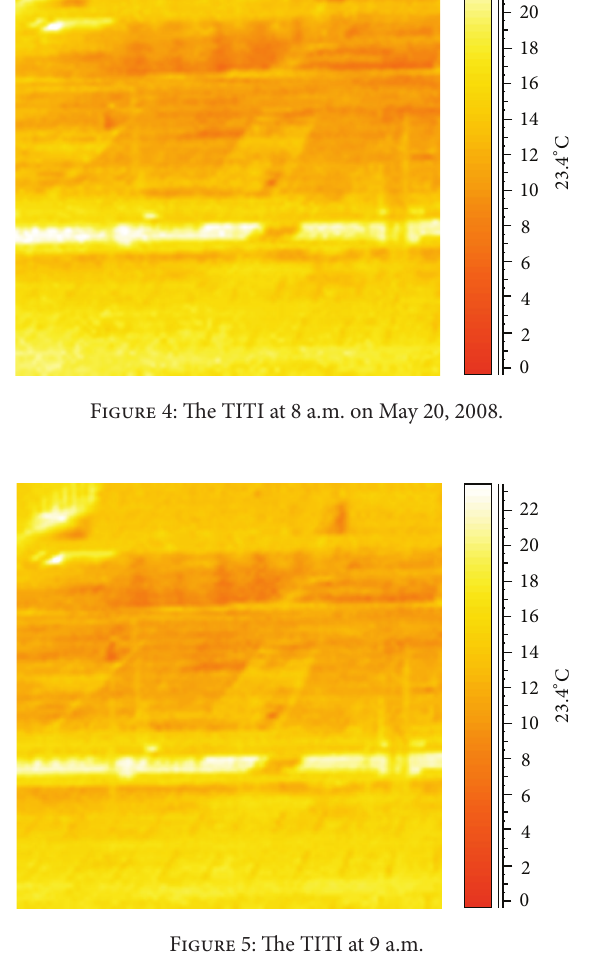
Figure 5: The TITI at 9